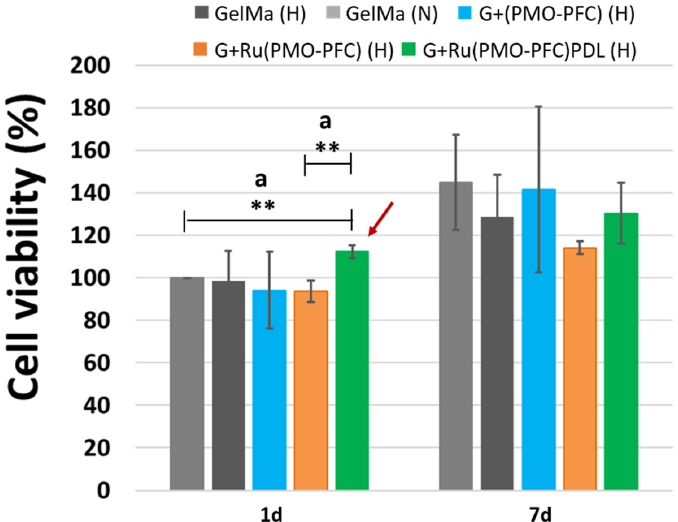
Figure 7. Comparison of the effects of G+(PMO-PFC), G+Ru(PMO-PFC), and G+Ru(PMO-PFC)PDL on cell viability under hypoxia conditions with the effects of the particle-free GelMa-based scaffold under normoxia conditions (H = hypoxia; N = normoxia). The dark red arrow shows the sample with the highest effect on cell viability. ANOVA: p < 0.01 (**), a = significant difference between two groups. Number of repeated experiments (N) = 3.